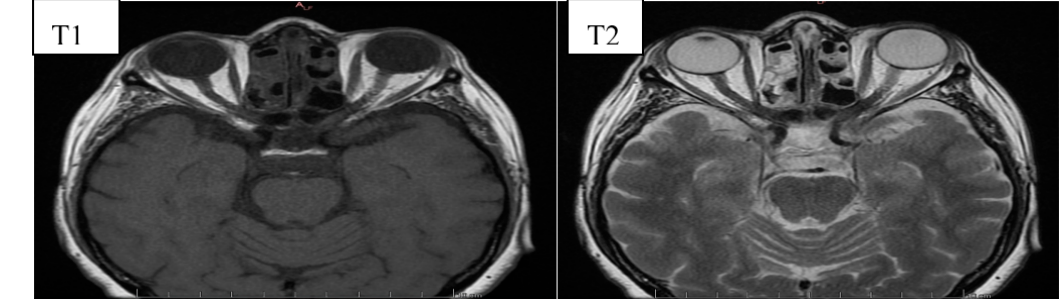
Figure 4. Transverse magnetic resonance imaging (MRI) image of the orbits of a 60 years old female patient with active GO, in whom the orbital changes were asymmetrical—the left orbit was more involved. The examination was performed in T1 and T2 sequences. The left inferior rectus muscle is significantly edematous, the left medial and lateral rectus muscle and the right inferior rectus muscle are also slightly edematous— the picture indicates active inflammatory orbital changes in the course of the underlying disease. Moreover, there is exophthalmos of the left eyeball and a slightly increased amount of the fluid in the left optic nerve sheath compared to the right side. There are no deviations of the lacrimal glands or the extra-conial adipose tissue.